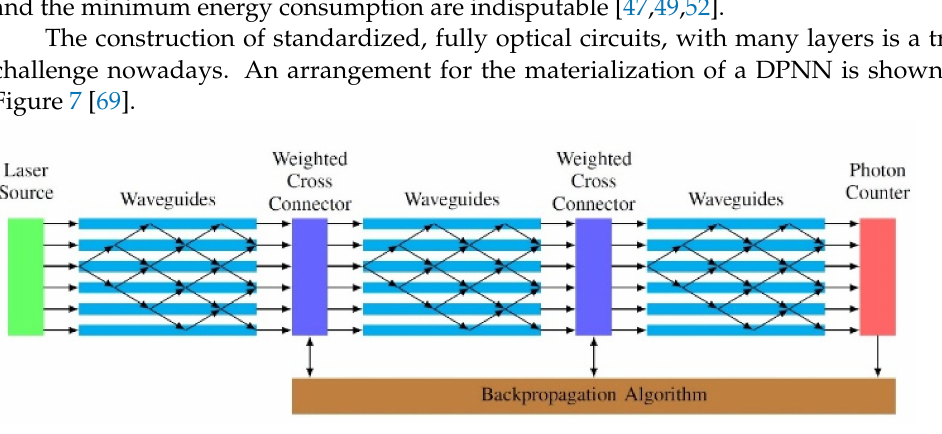
Figure 7. The architecture of a deep photonic neural network (DPNN)